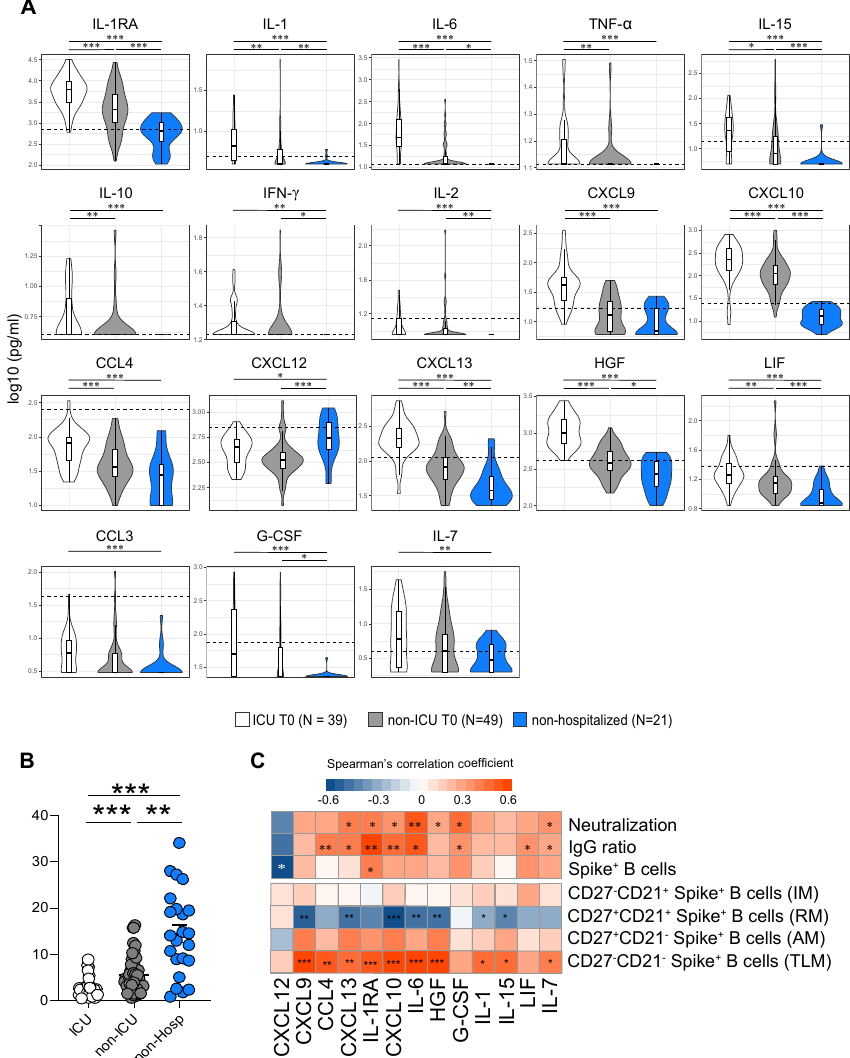
Figure 5. Serum cytokine, soluble cytokine receptor, chemokine, and growth factor profiles in ICU, non-ICU and non-hospitalized individuals at admission. ( A ) Levels of cytokines (IL-1 α , IL-1 β , IL-6, TNF- α , IL-10, IFN- γ , IL-2, IL-7, IL-15, chemokines (CCL4, CXCL9, CXCL10, CXCL12, CXCL13) and growth factors (HGH, LIF, G-CSF) in ICU (N = 39), non-ICU (N = 49) and non-hospitalized (N = 22) patients at the time of the admission. Dotted line represents the mean cytokine value calculated on serum from 450 healthy pre-pandemic controls. Stars indicate statistical significance between admission the three study groups. Statistical significance ( p -values) was obtained using Kruskal-Wallis test, using a Bonferroni correction. * = p < 0.05; ** = p < 0.01; *** = p < 0.001. ( B ) CXCL12/CXCL13 ratio and ( C ) Correlative analysis between the serum cytokine levels at the time of SARS-CoV-2+ test with the frequencies of total Spike+ B cells, with the frequencies of Spike+ IM, RM, AM and TLM B cells (ICU+ non-ICU: N = 24; non-Hospitalized: N = 15) and with the IgG ratio and the neutralizing abs titers, and at 6 months POS (ICU + non-ICU: N = 24; non-Hospitalized: N = 22).